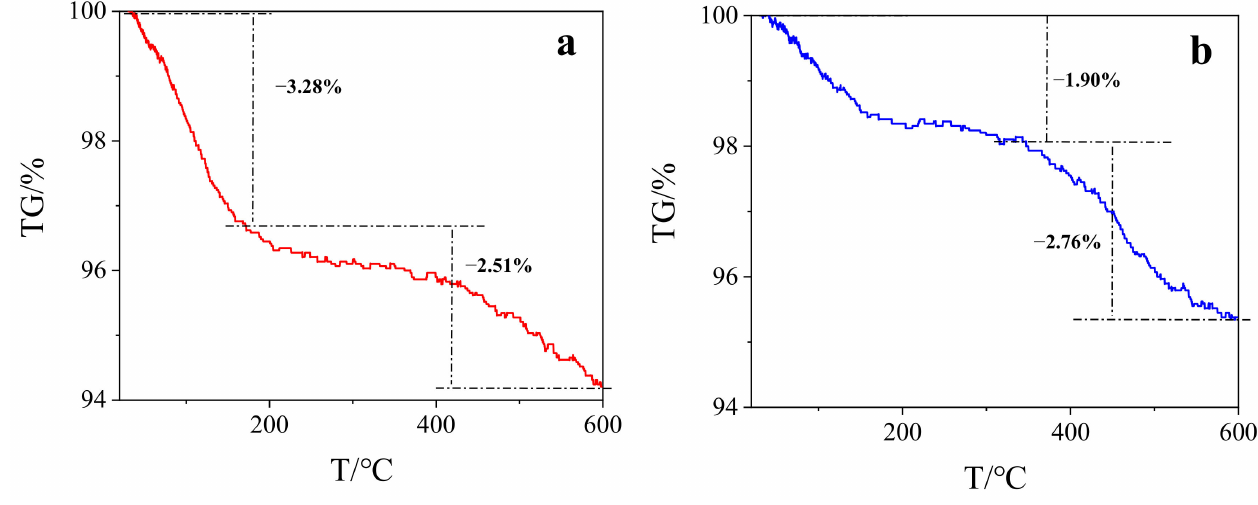
Figure 1. ( a ) TGA of BC; ( b ) TGA of